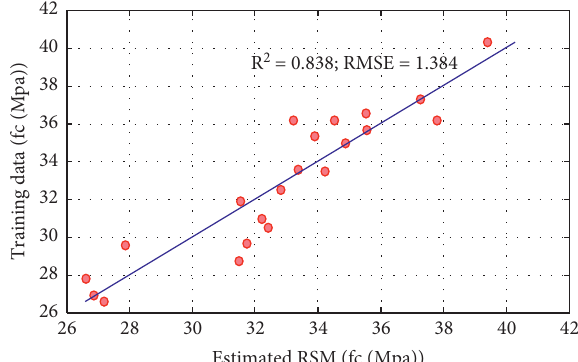
Figure 13: RSM compressive strength response error